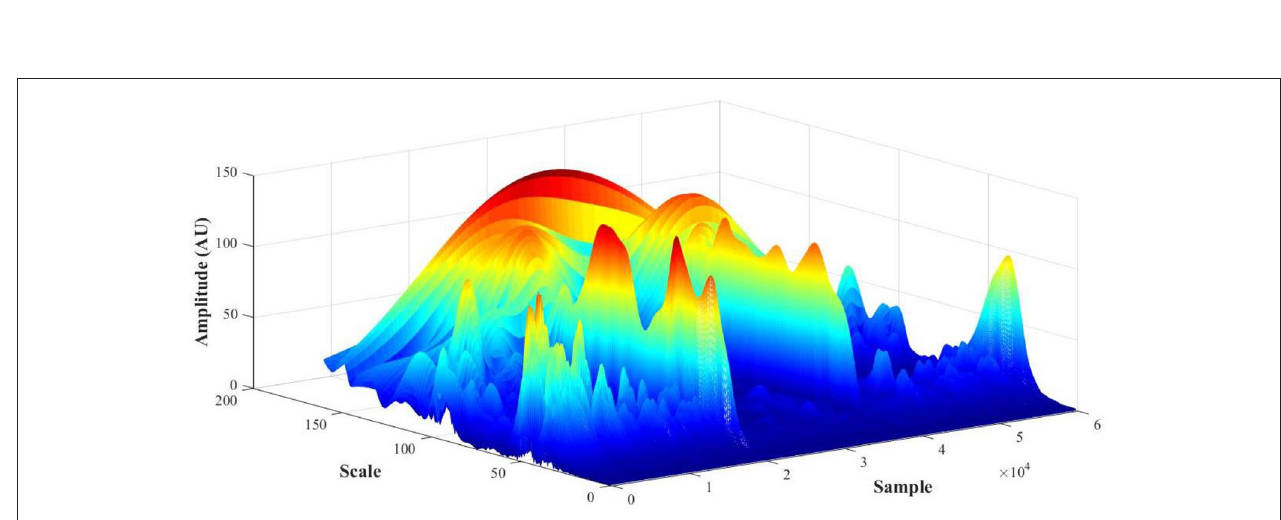
FIGURE 3 | PPG scalogram (scale vs. sample vs. amplitude) for a representative subject (female, 29 y.o., test foot).